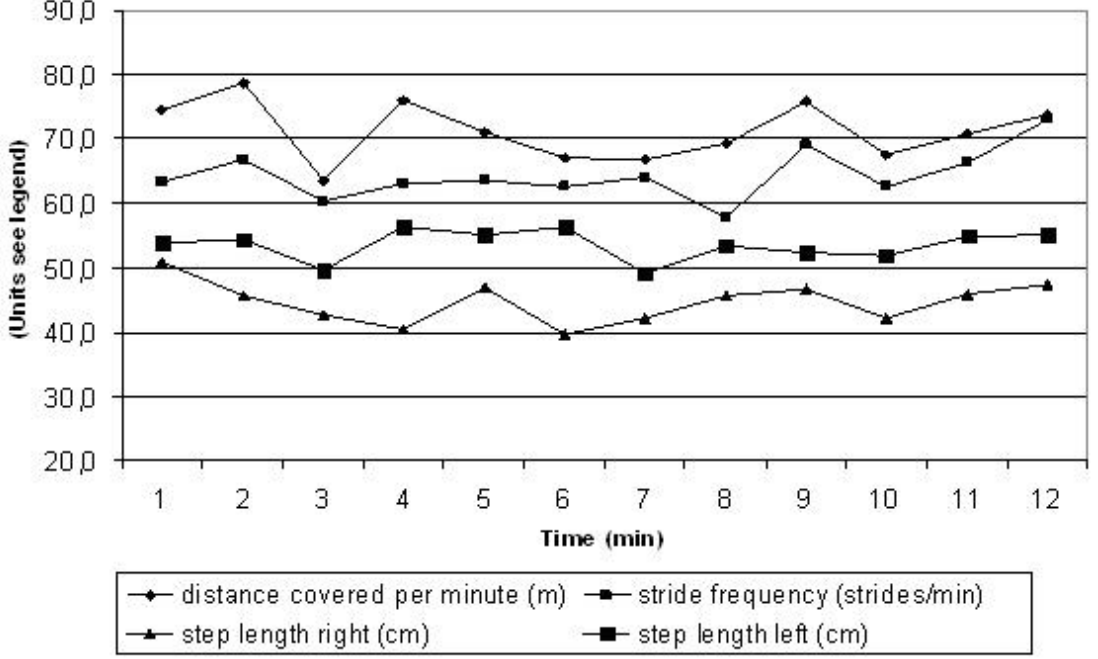
Figure 3. Changes in kinesiologic parameters over 12 minutes of Cooper